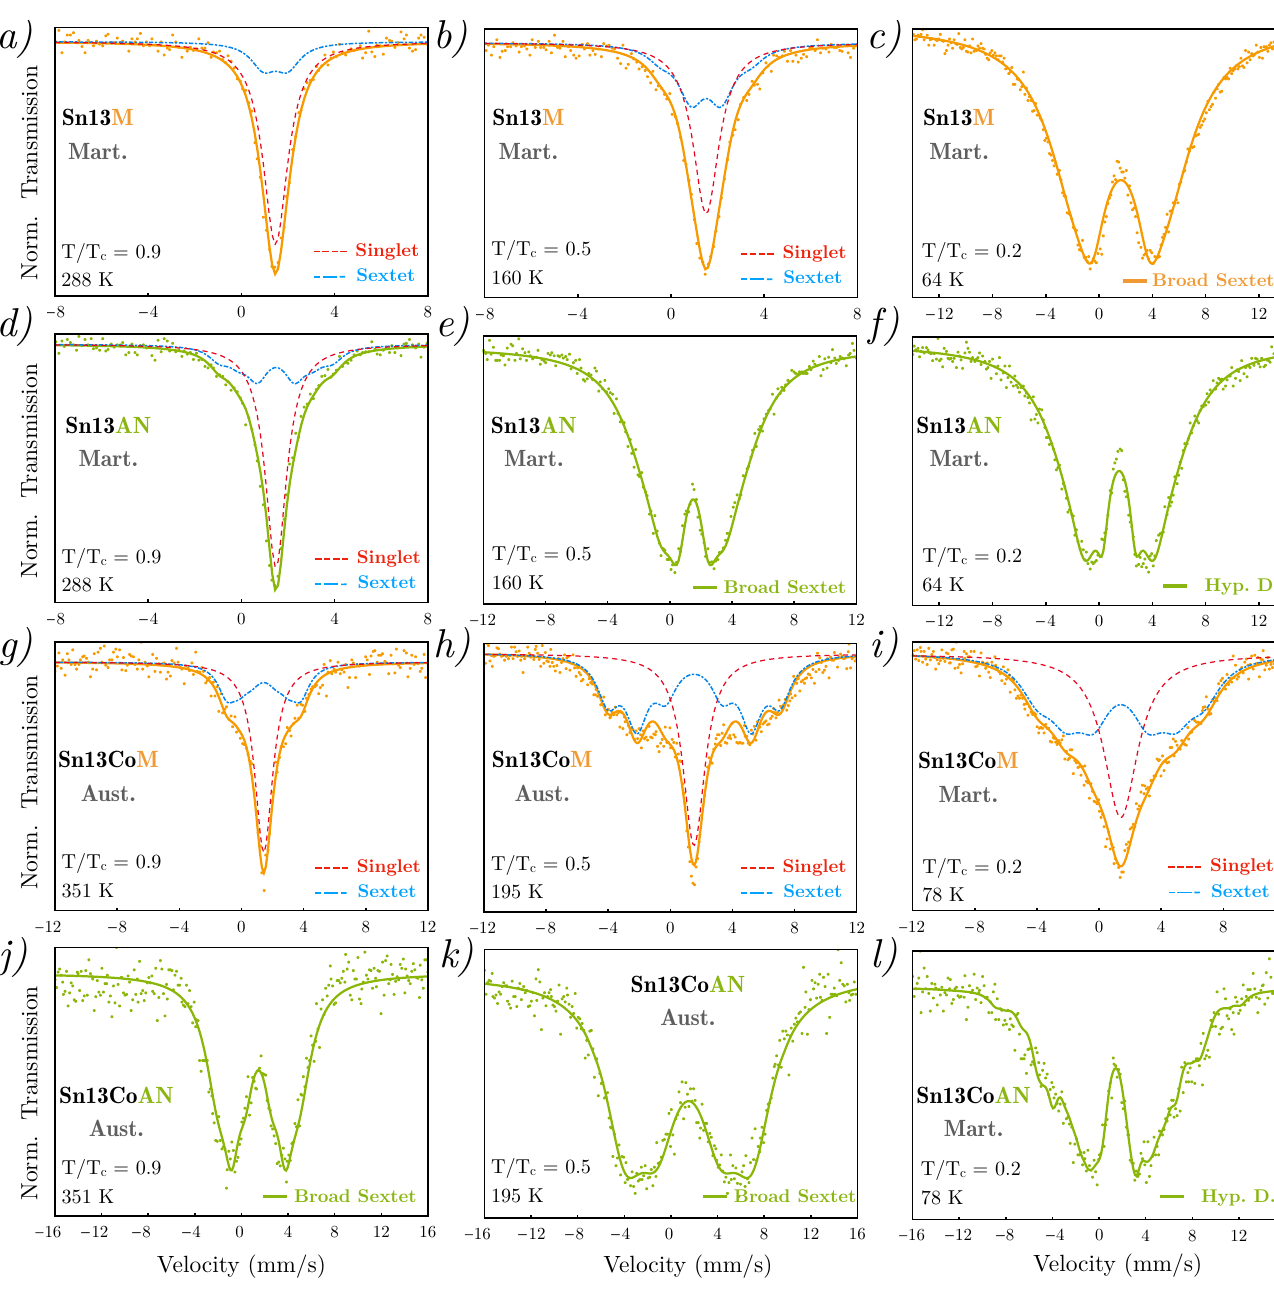
Figure 4. 119 Sn Mössbauer spectra for the annealed (AN) and milled (M) state of ( a – f ) Sn13 and ( g – l ) Sn13Co samples measured at normalized temperatures T / T c = 0.9,0.5 and 0.2. The fitting has been carried out using two discrete components (singlet and sextet), a broad sextet or using a distribution of hyperfine fields (Hyp.